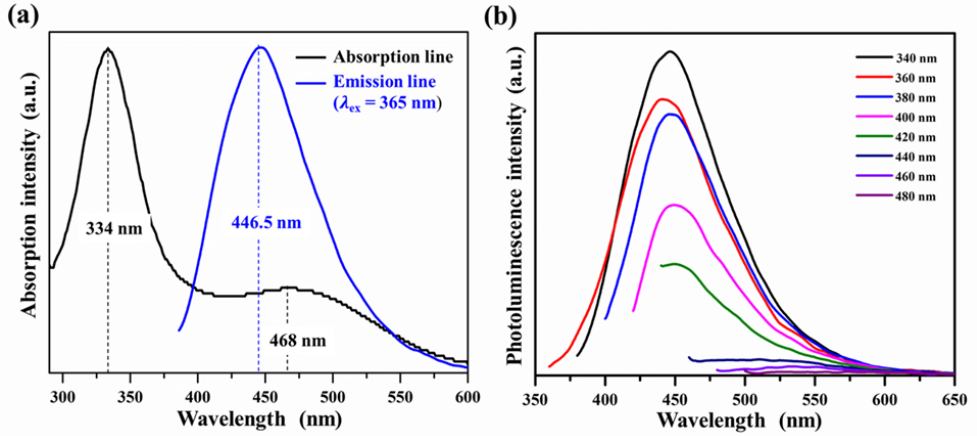
Figure 4. ( a ) UV-vis absorbance spectra of GQDs and ( b ) PL emission spectra of GQDs at different excitation